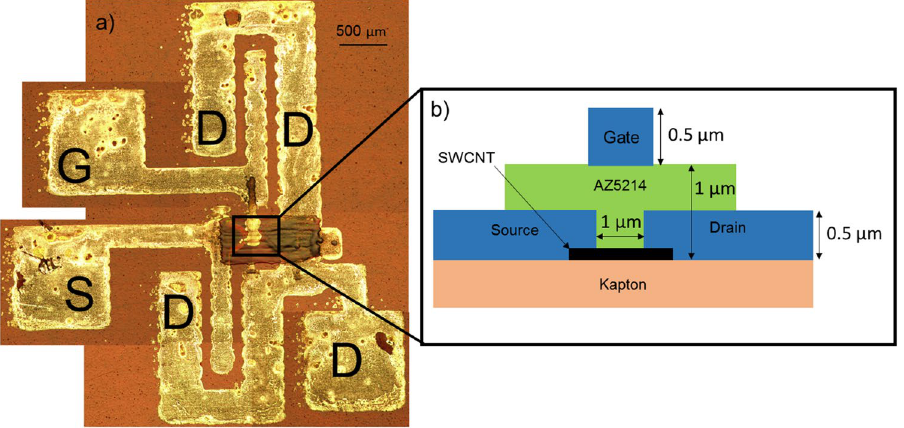
Figure 1. ( a ) A composite optical microscope image of the final completed device used for high frequency testing. G is the gate electrode, S is the source electrode, while the D’s are the common drain electrode. The structure is designed to allow RF testing with 500 micron pitch GSG probes. ( b ) A cross section of the top gate transistor design. Source, drain, and gate were all printed using nanoparticle silver